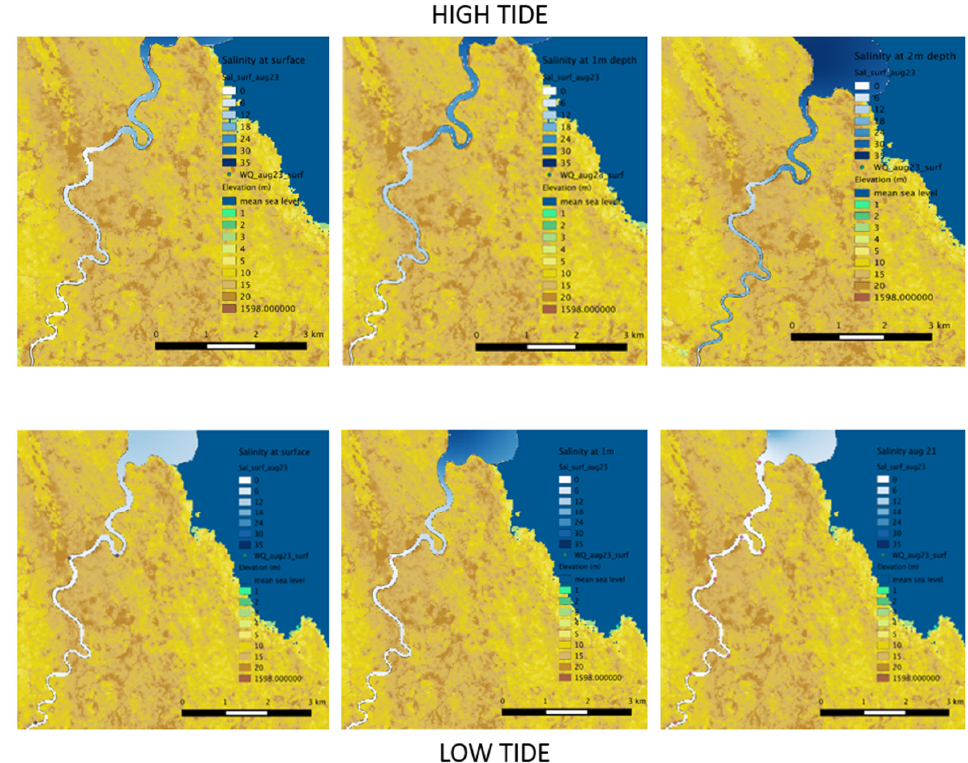
Figure 6. Salinity profiles in the Wami Estuary: Top panel shows salinity at surface, 1 m and 2 m depths during high tide (23 August). Bottom panel left and center shows salinity at surface and 1 m depth during low tide (23 August). Bottom panel right shows salinity at the surface during low tide on 21 August. Deeper blue indicates higher salinity (upper legend from white to blue in each map). Lower legend indicates land topographic elevation.